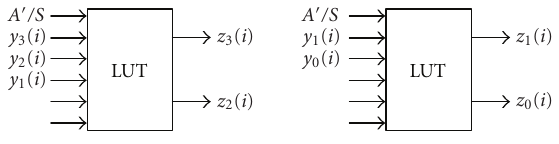
Figure 15: FPGA 9’s complement circuit for AS- I.